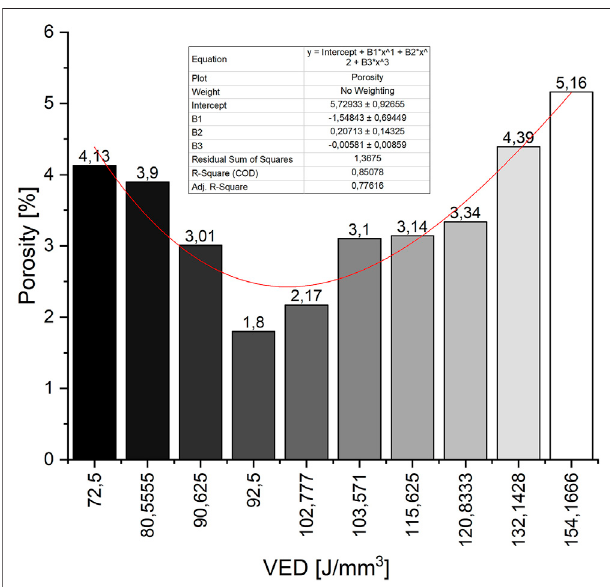
FIGURE 12 | In the case of the Cantor alloy, the degree of porosity is a function of applied VED.